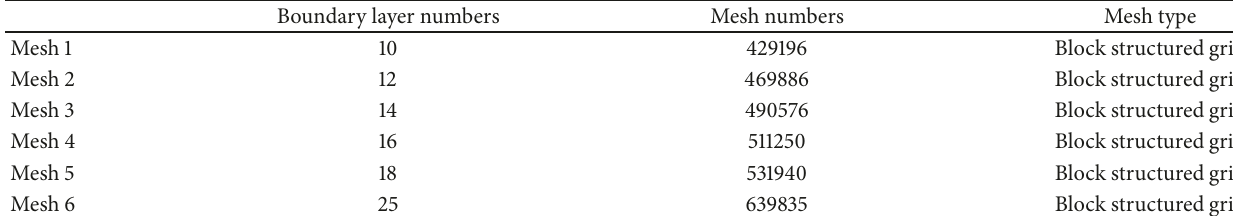
Figure 11: Comparison of vertical RMS velocity in different surge line diameters. Table 3: Different mesh numbers for numerical